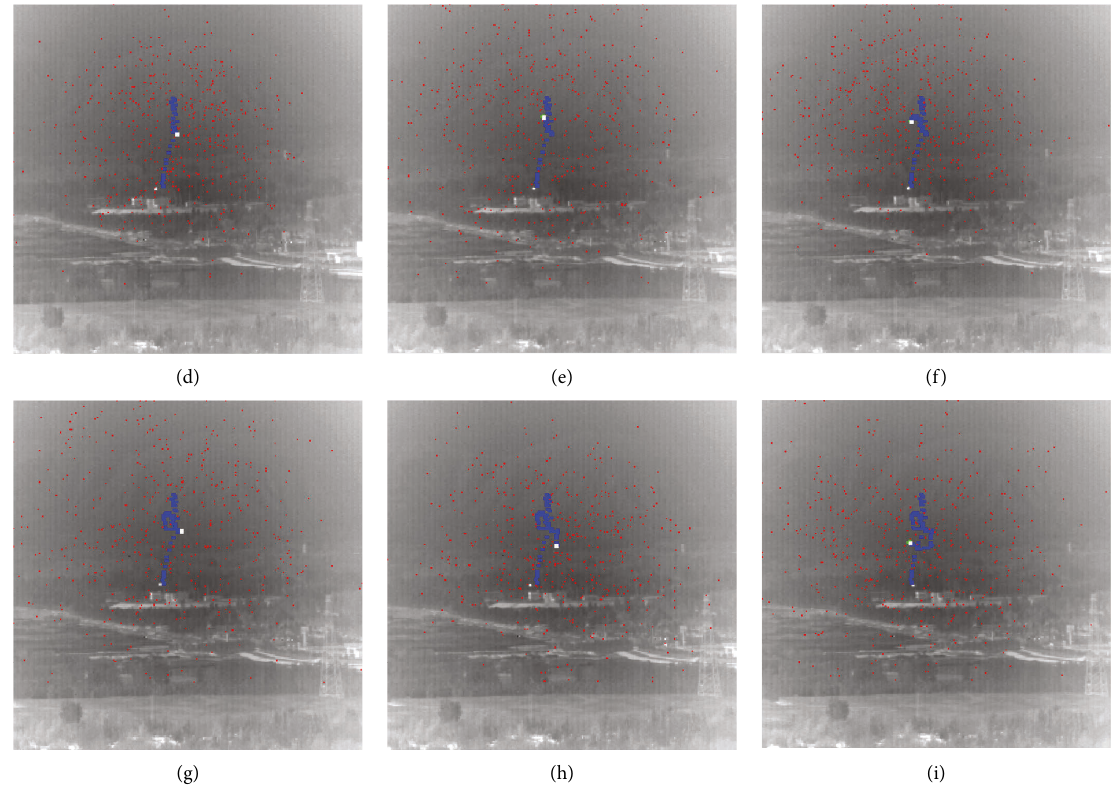
Figure 2: Tracking results of the fast-maneuvering target. The white dot is the target. The blue dot is the estimation of the trajectory. The red dots are particles. (a) The 400th frame. (b) The 410th frame. (c) The 420th frame. (d) The 430th frame. (e) The 440th frame. (f) The 450th frame. (g) The 460th frame. (h) The 470th frame. (i) The 480th frame.